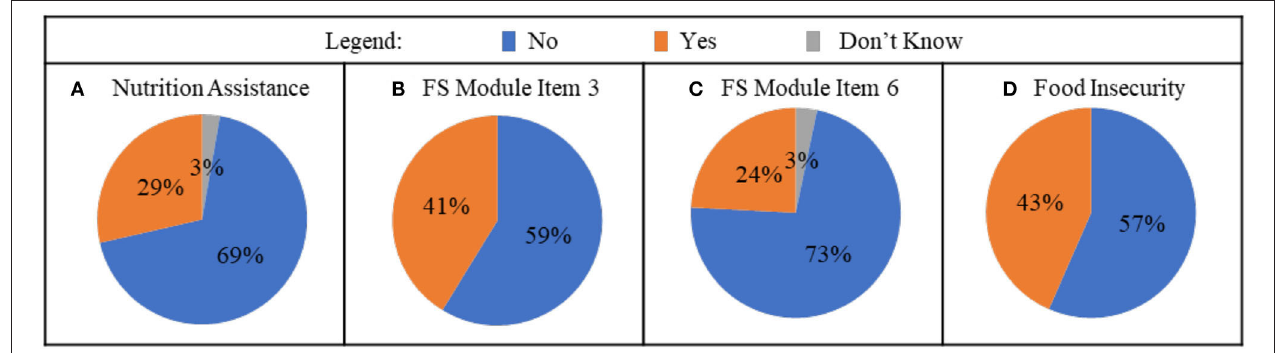
FIGURE 1 | Frequency of informants that reported (A) they receive nutritional assistance, (B) an affirmative response to USDA Food Security Module Item 3, (C) an affirmative response to USDA Food Security Module Item 6, and (D) composite food insecurity measurement.